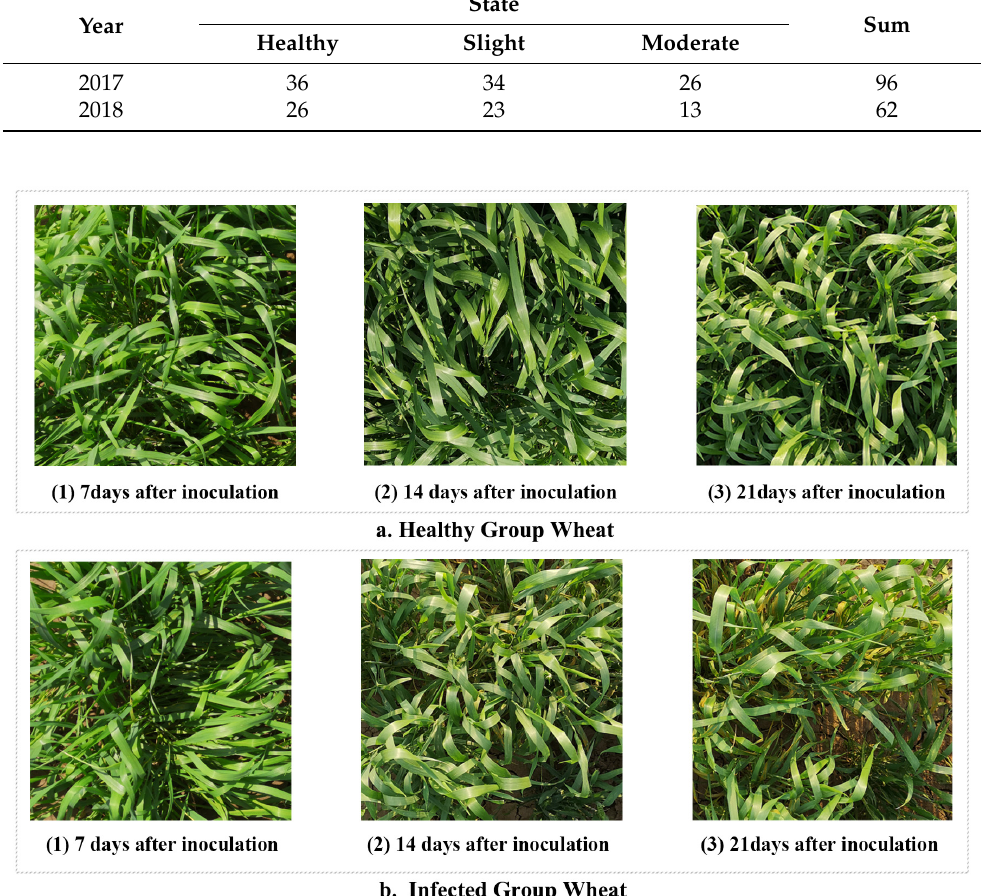
Figure 3. Samples of the inoculation of stripe rust during different infection periods; ( a ) Healthy group wheat; ( b ) Infected group wheat.